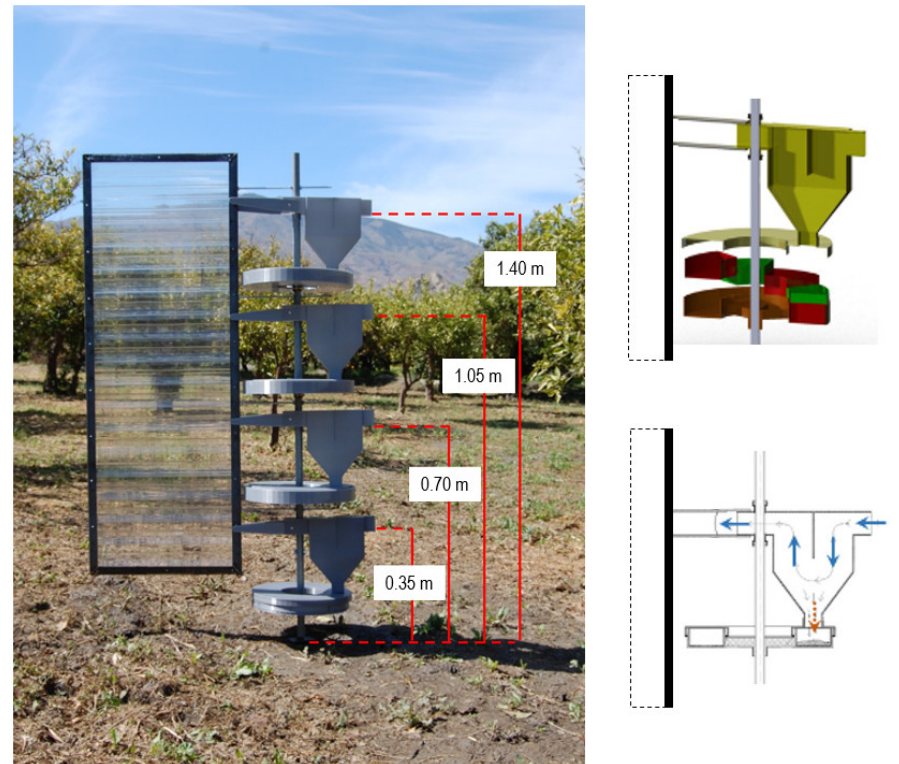
Figure 2. Mast and vane with collectors at different heights. Operating scheme.